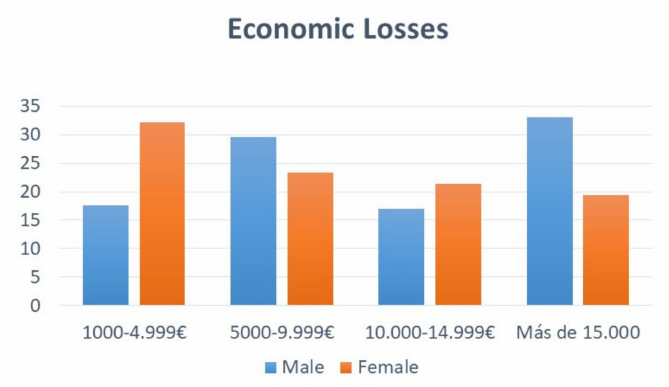
Figure 1. Economics of female and male losses.